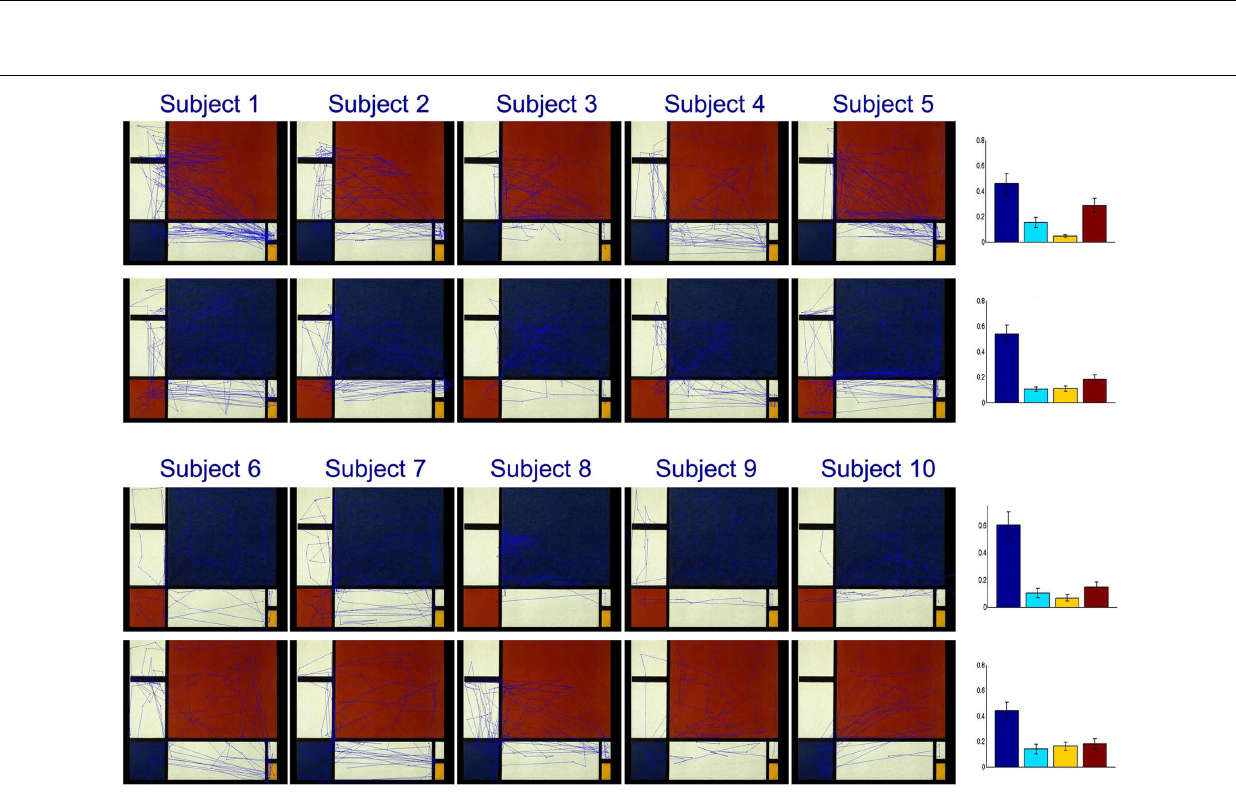
original (modified) version first.The graphs on the right of each row show the average relative number of fixations in each region of interest for the five